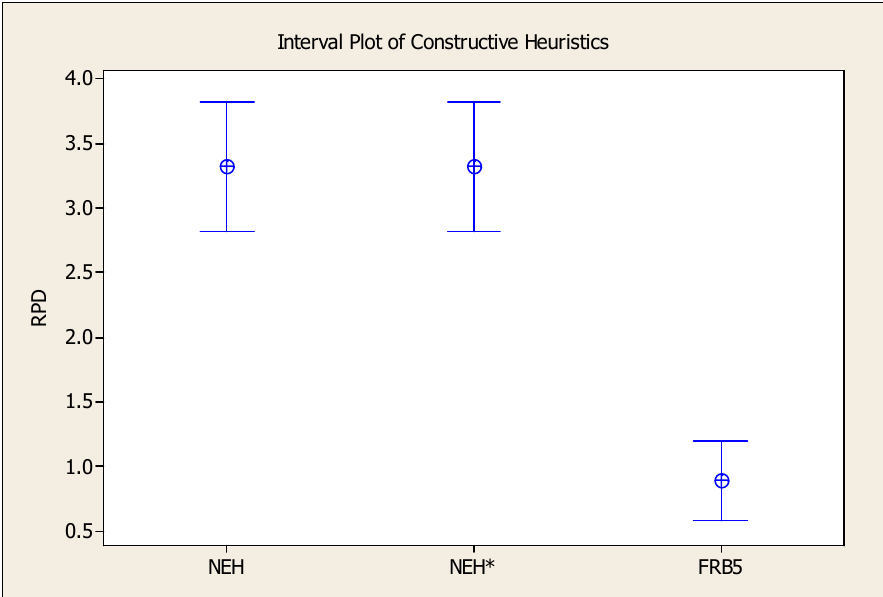
Figure 6. Interval plot for small VRF instances. Table 6. Computational results of algorithms with T max = 15 × n × m milliseconds (The bolds show better